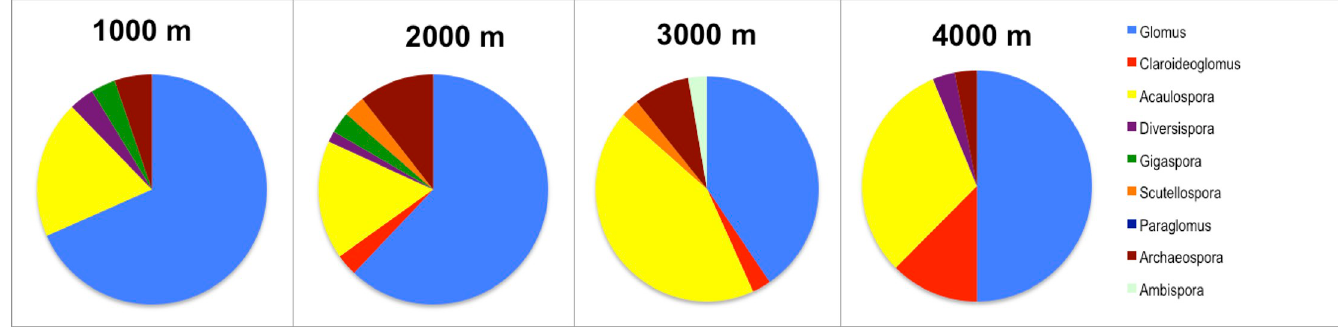
Fig 5. Relative abundance of Glomeromycotina genera for each elevation level in number of OTUs. The frequency of Glomus OTUs was high at all levels, the frequency of Acaulospora OTUs increased in particular at 3000 masl and also at 4000 masl in comparison to 1000 and 2000 masl.